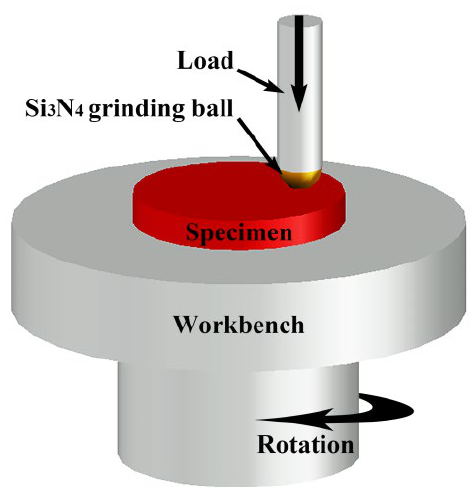
Figure 4. Schematic diagram of friction wear test.